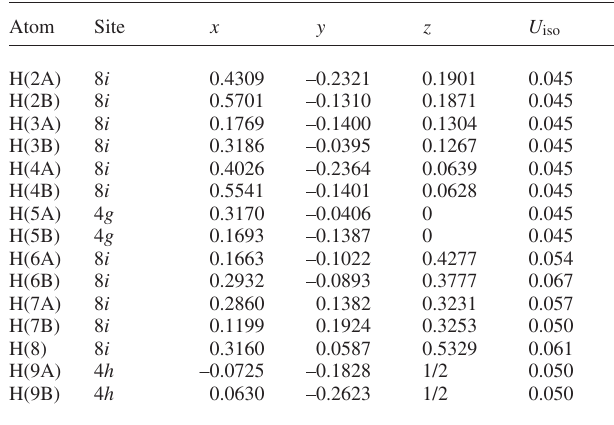
Table 2. Atomic coordinates and displacement parameters (in Å 2 ) .